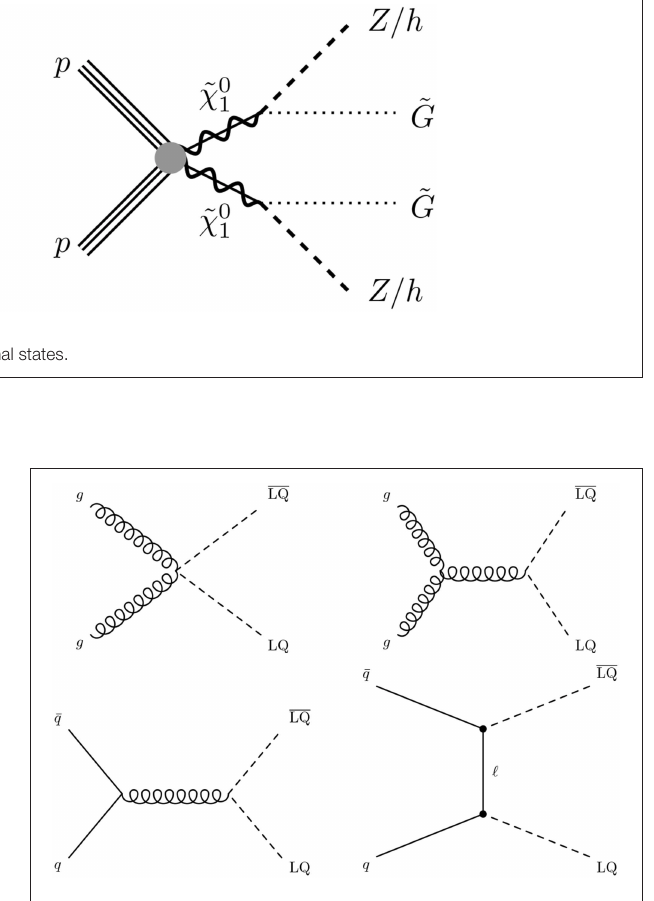
FIGURE 12 | Representative diagrams for leptoquark pair production at pp colliders. Dots denote the LQ- q - ℓ